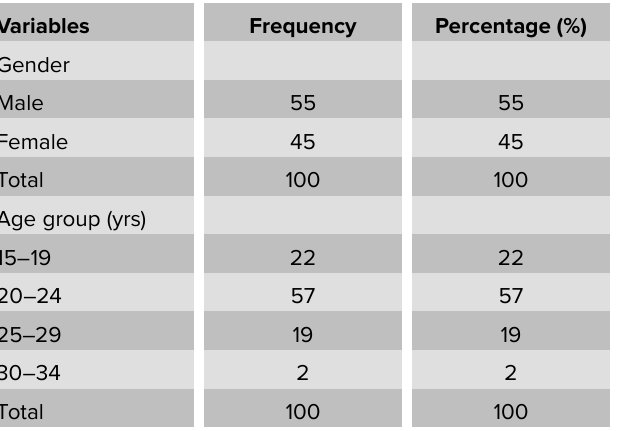
TABLE 1: Gender and age group distribution among voluntary blood